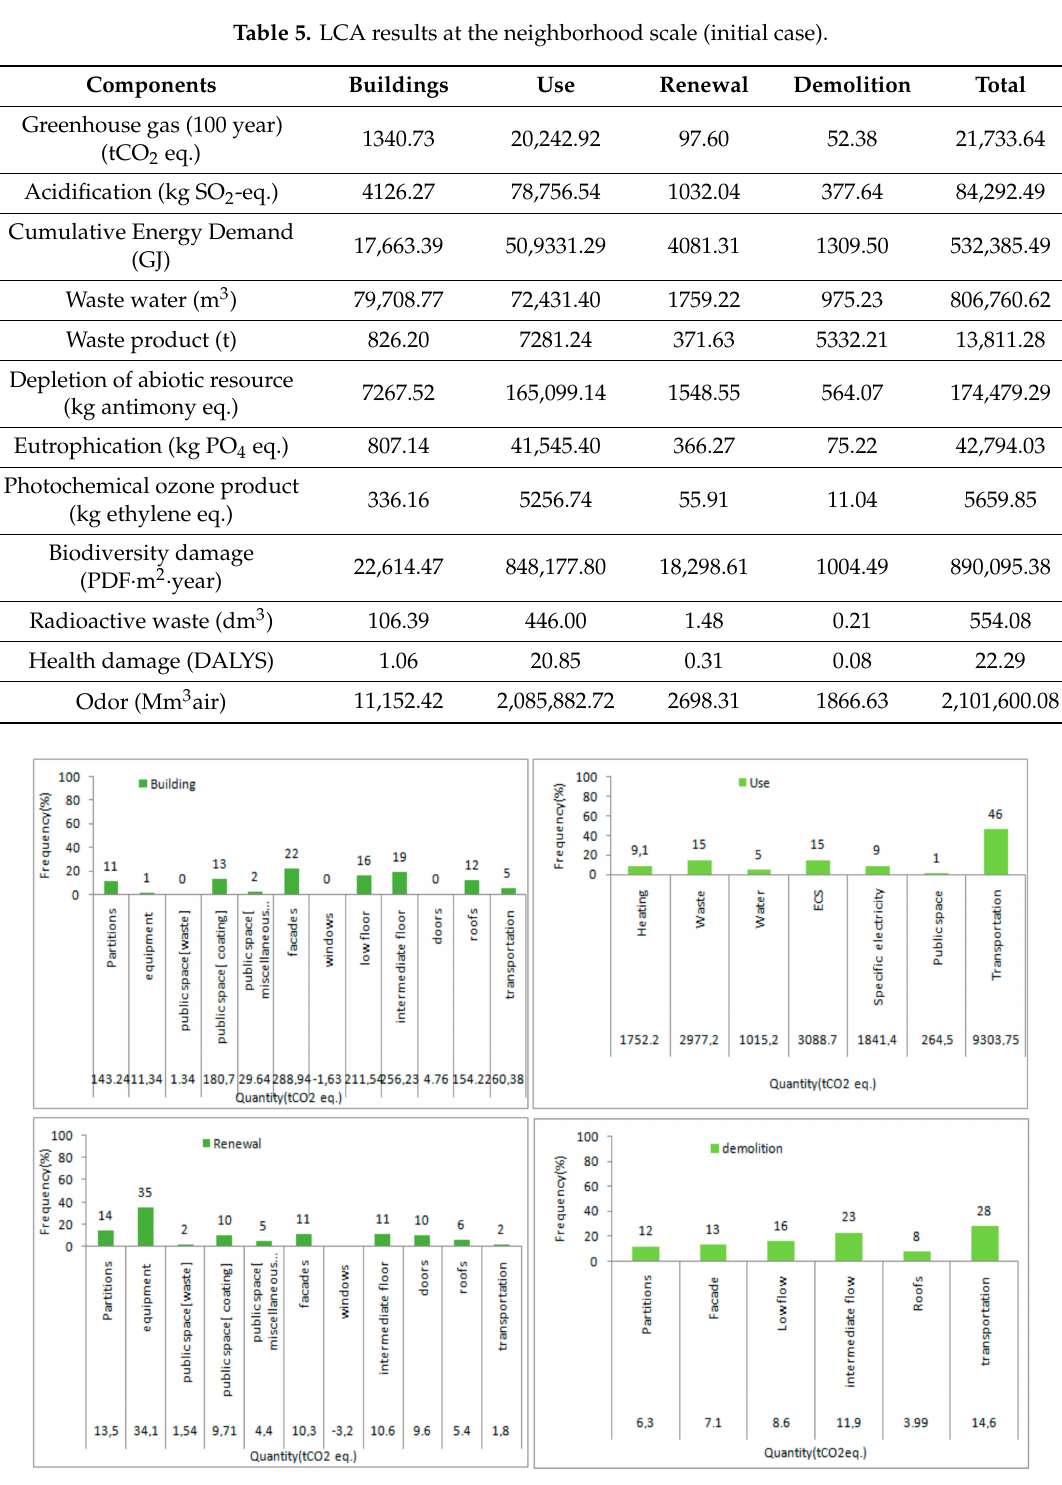
Figure 6. Detailed results of the calculation of the “greenhouse e ff ect” impact at the neighborhood level (initial